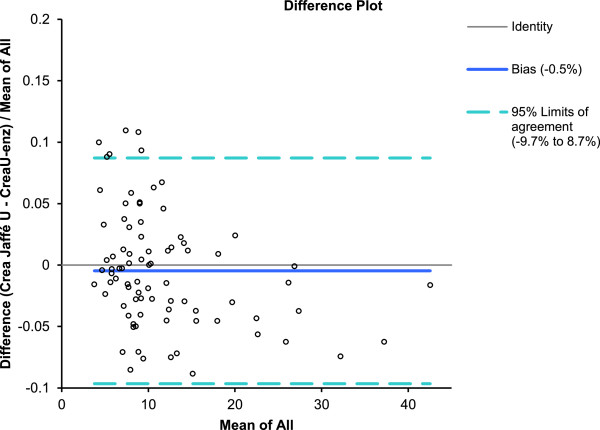
Bland Altman plot illustrates a mean difference of 0.2 mg/dL, equal to 0.4% in creatinine concentration measured. There is also an impact of the creatinine concentration on the direction and extent of this difference between both assays. A higher creatinine urine concentration (>25 mg/dL) results in a higher enzymatic compared to a Jaffe assay, while the reverse is true in lower urine concentrations (<10 mg/dL) (X-axis = mean of all, mg/dL; Y-axis = difference [creatine in urine, Jaffe – creatinine in urine, enzymatic/mean of all]).